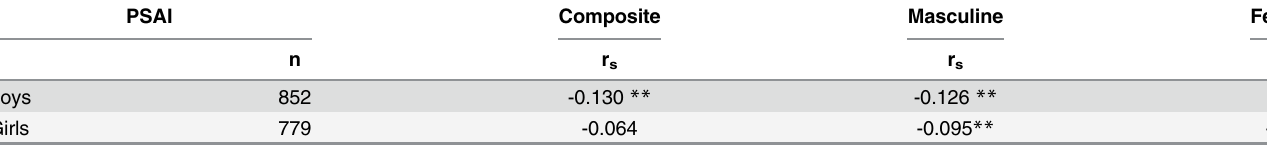
Table 4. Analyses of the relationship between 2D/4D and PSAI in Spearman ’ s rank-order correlation. PSAI